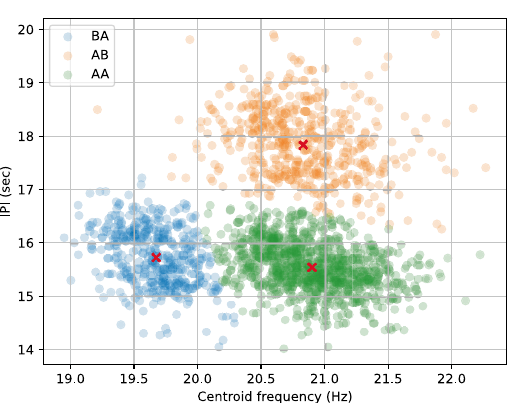
Figure 9. Scatter plot of pulses center frequency against the time until the next pulse (IPI). Colors denote the GMM assignation, whose means are marked with